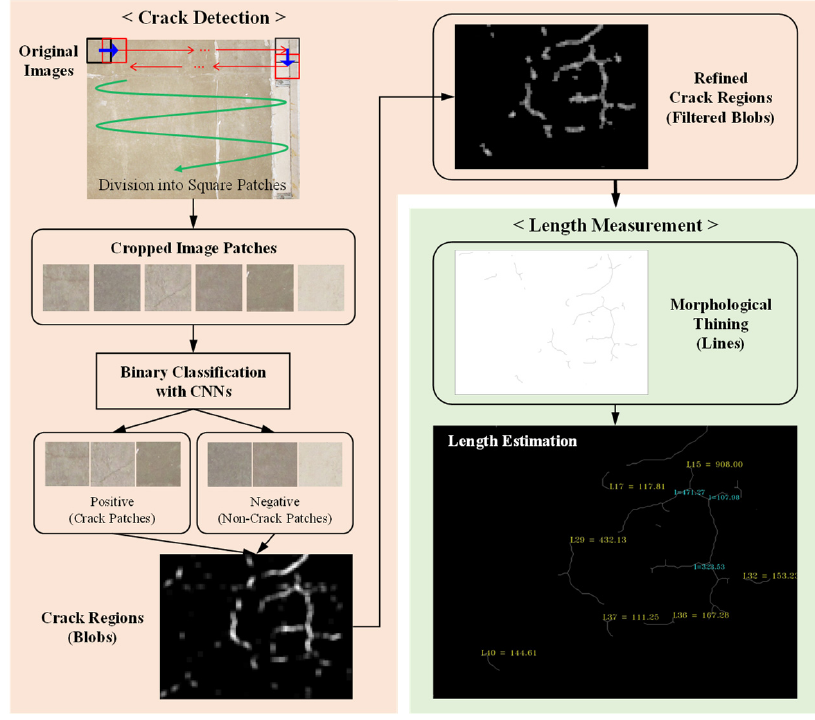
Figure 1. Proposed framework of the crack detection and length measurement.